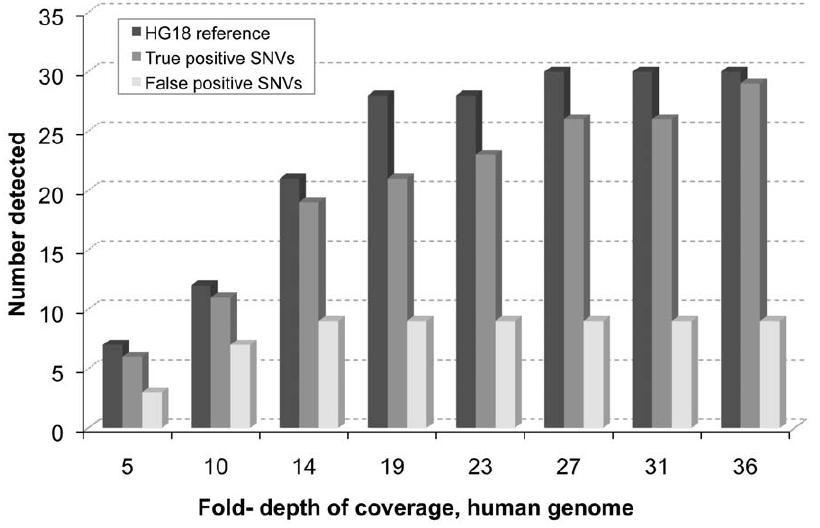
Figure 1. Detection of true positive versus false positive SNVs in lobular breast cancer. TASR was run incrementally on up to 2 billion, 51 and 76 nt lobular breast cancer NGS whole-genome shotgun reads, providing 5 to 36-fold coverage of the 3 Gbp human genome. We used as targets 51 nt sequences containing one of 31 SNVs detected by NGS read alignment and confirmed by Sanger sequencing (true positive), 31 matching sequences containing the reference base instead (reference) and 31 detected by NGS read alignment but not confirmed by Sanger sequencing (false positive). Although close to twice as much WGSS data had been generated from the LBC sample, we see that a fraction of that ( , 19-fold) is sufficient for confirming most (68%) true positive